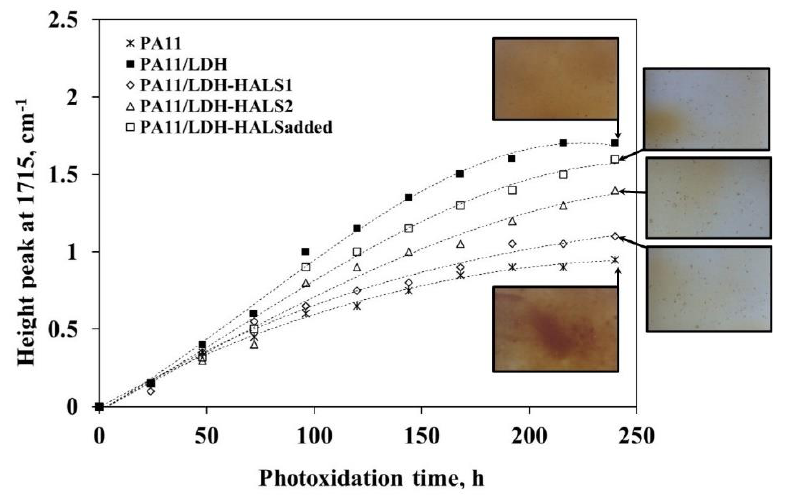
Figure 9. Height peak at 1715 cm − 1 for neat PA11 and PA11-based nanocomposite films as a function of photo-oxidation time.